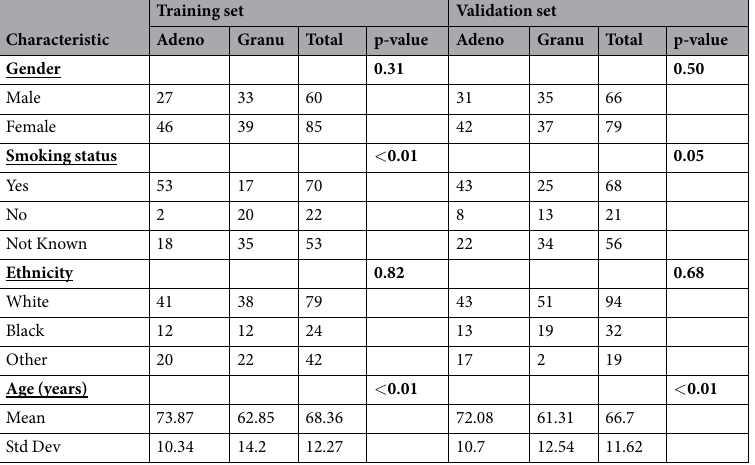
Table 3. Statistical significance testing between patients parameters and disease outcome for both training and validation cohorts. The p-values were computed using Students t test for continuous variable and Fishers exact test for categorical data. Statistically significant difference was indicated by p < 0.01.